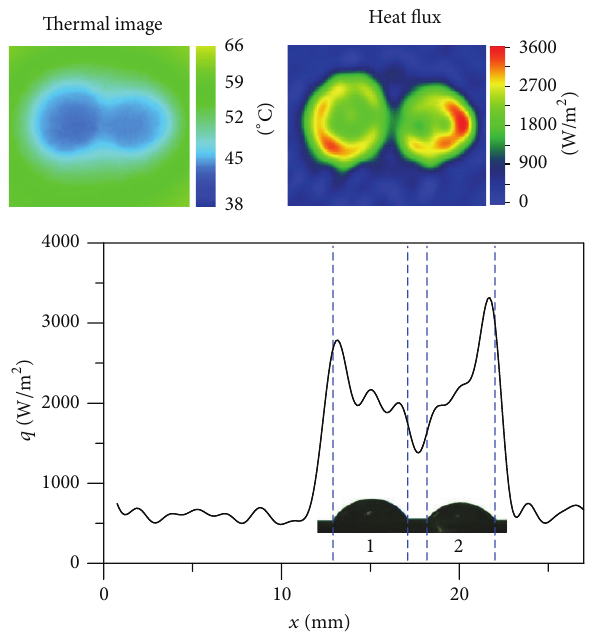
Figure4:DistributionofheatfluxdensitybasedonCauchyproblem solution for two drops, 𝑞 av = 653 W/m 2 : (1) 𝐷 = 4.1 mm, 𝐻 = 1.085 mm, 𝑉 = 7𝜇 L, and 𝜃 = 58 ∘ ; (2) 𝐷 = 4.1 mm, 𝐻 = 0.903 mm, 𝑉 = 5.73 𝜇 L, and 𝜃 = 52 ∘